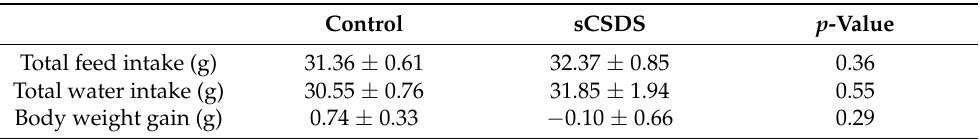
Table 1. Feed intake, water intake, and body weight gain during the sCSDS period (Day 0–11) in BALB/c male mice (Control mice; n = 4, sCSDS mice; n = 7).